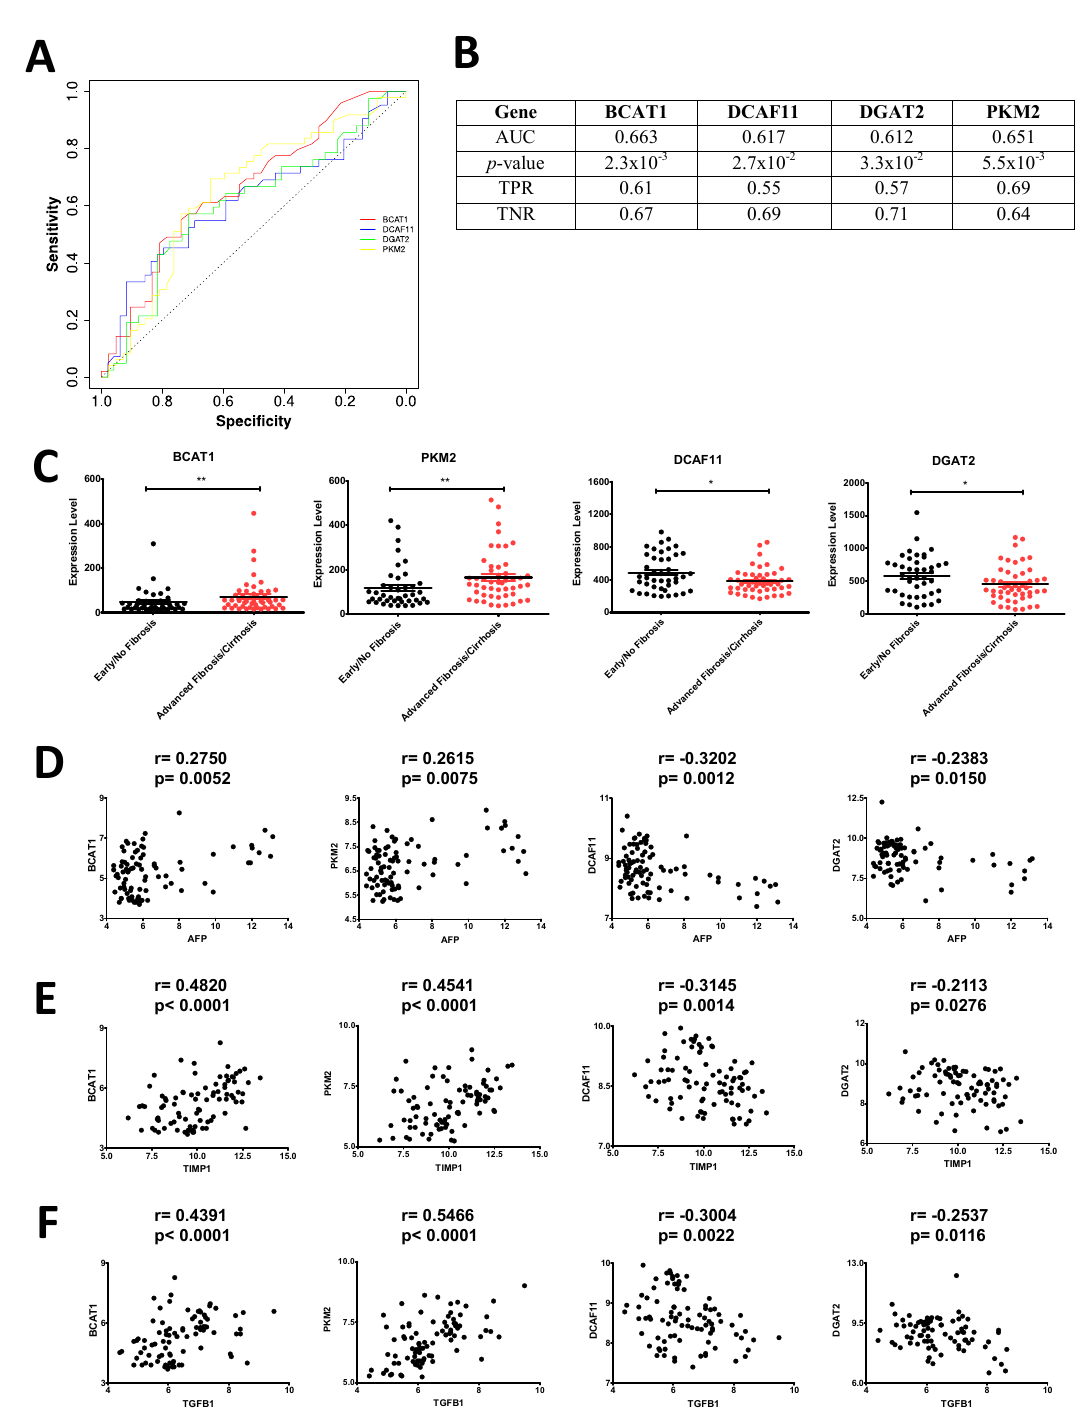
Figure 8. Selected genes in the HCC-AILD GRN show promising prospect as biomarkers as well as therapeutic targets. Kaplan–Meier survival plots of hub genes (genes with ≥ 4 links) displaying ( A ) progression free survival (PFS), ( B ) disease specific survival (DSS) and ( C ) overall survival (OS). N denotes the number of cases considered for each calculation. Analyzed on KM plotter. Bar diagrams at the bottom right indicate median survival for high and low expression condi- tions of individual genes.